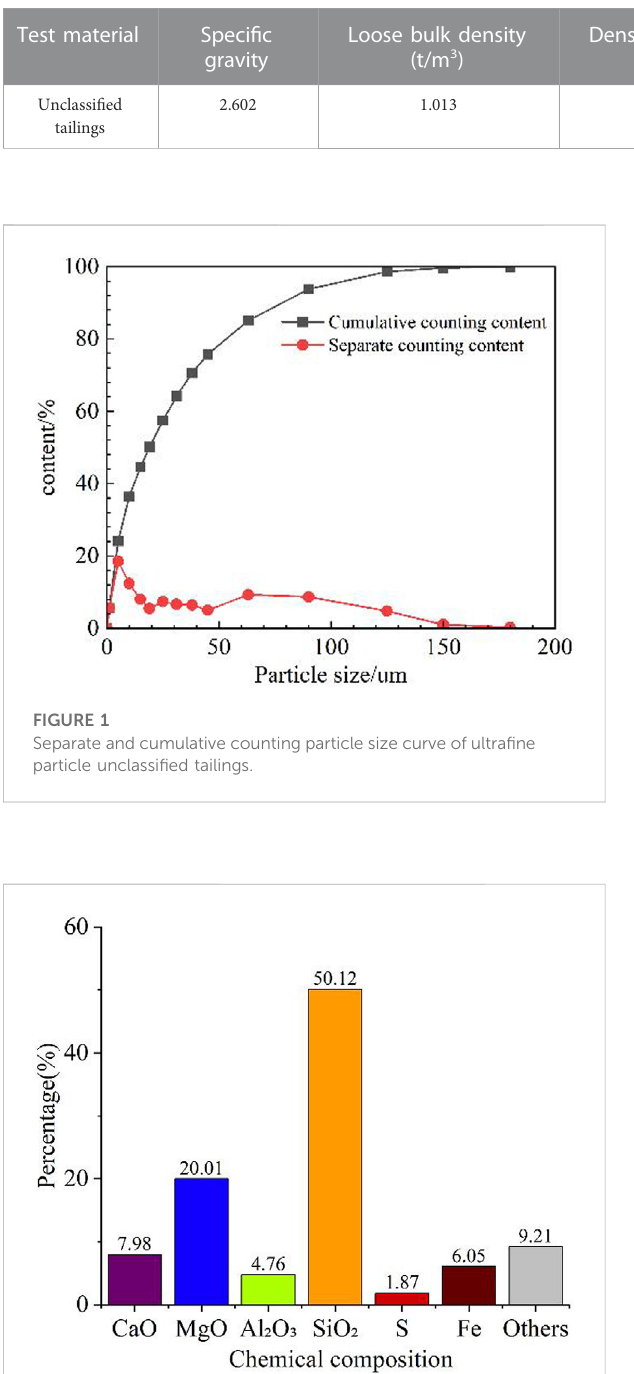
FIGURE 2 Determination of the percentage of tailings ’ chemical